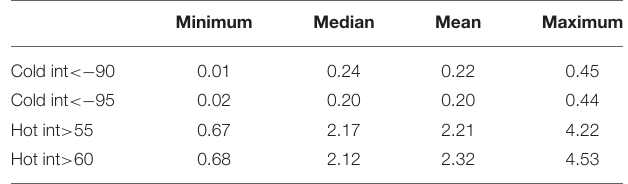
Frontiers in Environmental Science |